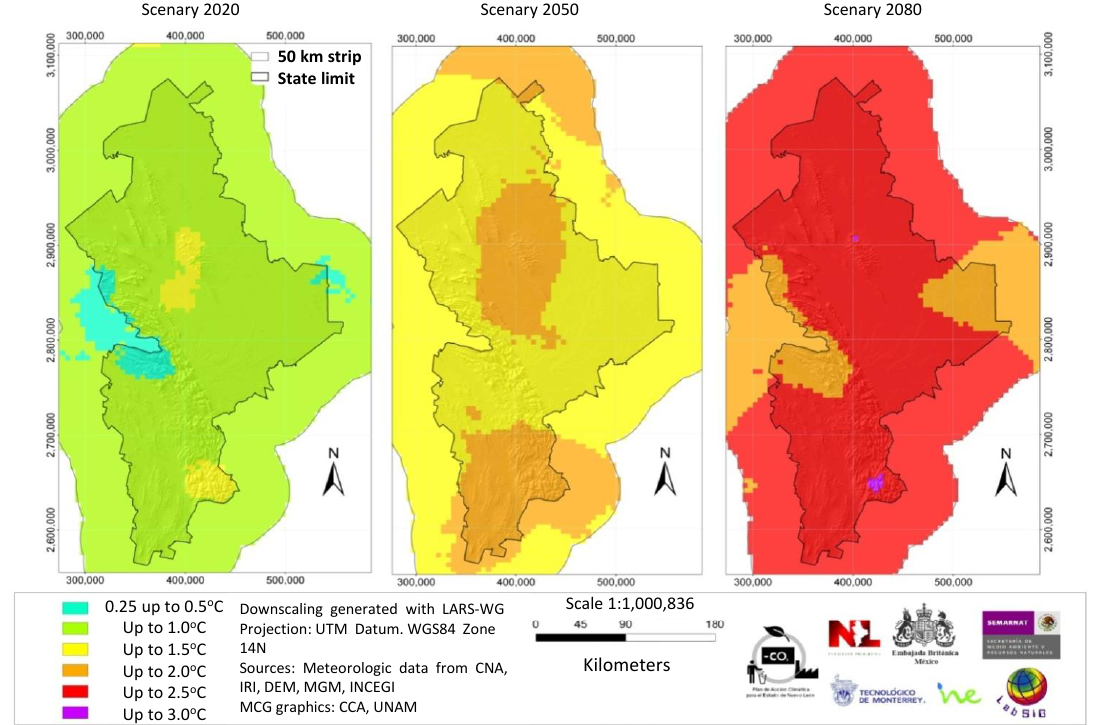
Figure 4. Changes in the mean minimal temperature in the A1B scenario for the 2020, 2050, and 2080 year periods, compared with the base period 1960 – 1990.